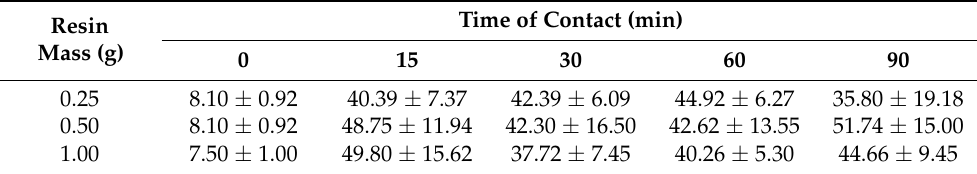
Table 5. Purification ratios (%) obtained for Bio-Rad 50W-X8 200–400 mesh (results correspond to the average of 3 replicates ± standard